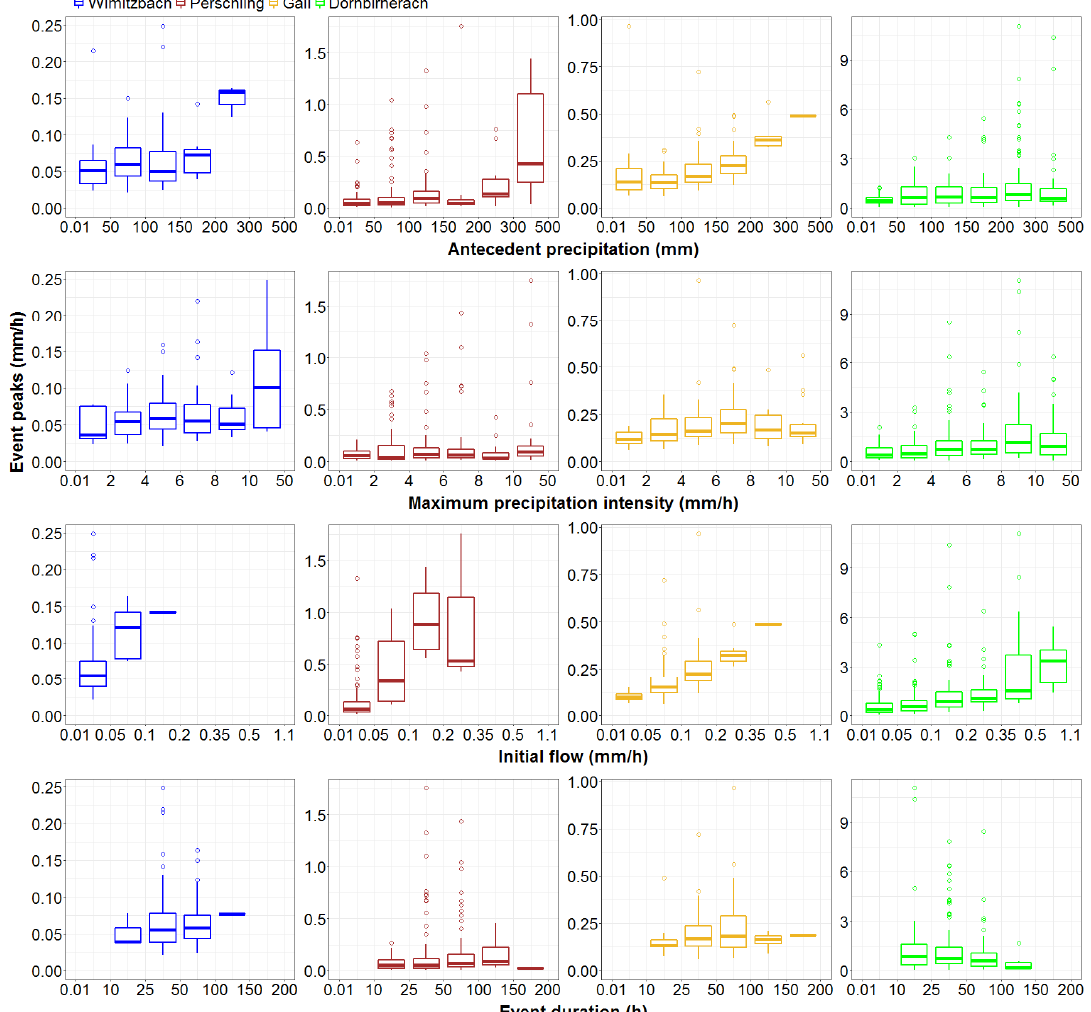
Figure 7. Variability of event peaks (Qp) for different classes of antecedent precipitation, maximum precipitation intensity, initial flow prior to the event, and event duration in four selected catchments: Dornbirnerach, Gail, Wimitzbach, and Perschling. The changes are evaluated for events with precipitation volumes less than 50 mm.